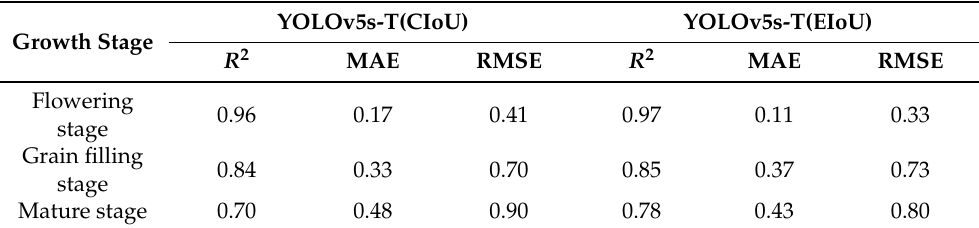
Figure 11. Fitting results of the number of spikelets in images of each growth stage ( a ) R 2 of YOLOv5s-T(CIoU) and YOLOv5s-T(EIoU) in the flowering stage, ( b ) R 2 of YOLOv5s-T(CIoU) and YOLOv5s-T(EIoU) in grain filling stage, ( c ) R 2 of YOLOv5s-T(CIoU) and YOLOv5s-T(EIoU) in the mature stage. Table 4. Comparison of spikelet counting results between YOLOv5s-T(CIoU) and YOLOv5s-T(EIoU) at different growth